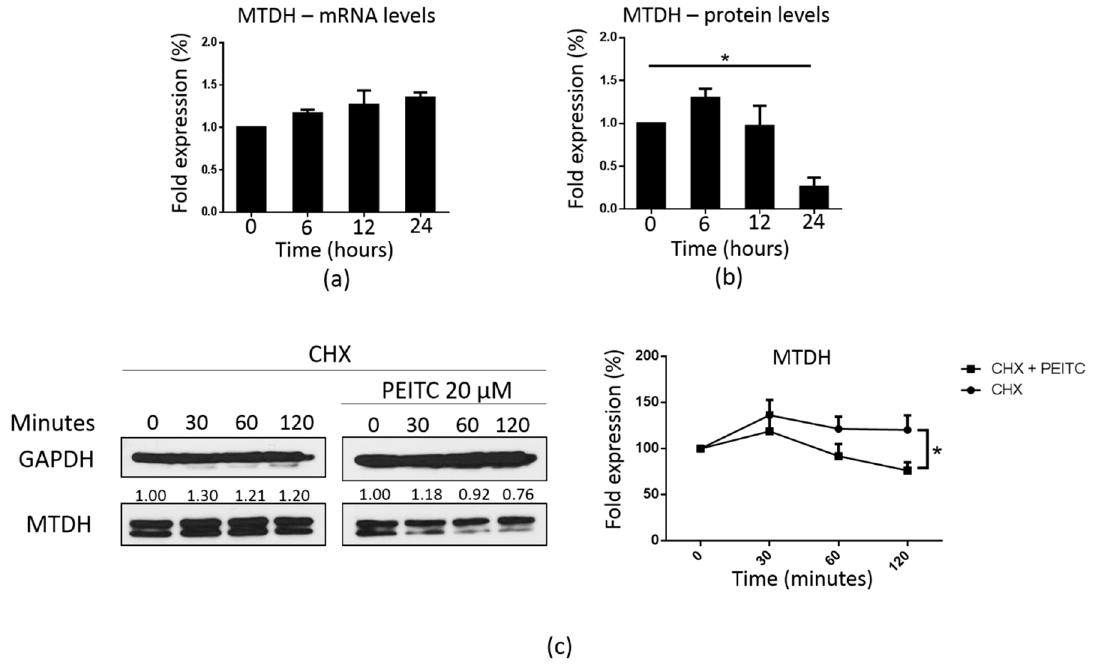
Figure 8. PEITC regulates MTDH post-transcriptionally. ( a ) Real-time PCR analysis of MTDH following PEITC treatment (10 µ M for 6, 12, or 24 h). ( b ) Western blot analysis was performed to analyze MTDH expression following PEITC exposure (10 µ M for 6, 12, or 24 h), similar to Figure 7a. ( c ) Western blot analysis of the MTDH protein expression following co-treatment with PEITC (20 µ M) and cycloheximide (100 µ g / mL) for 30, 60, or 120 min; * p < 0.05; results are presented as mean ± standard deviation.